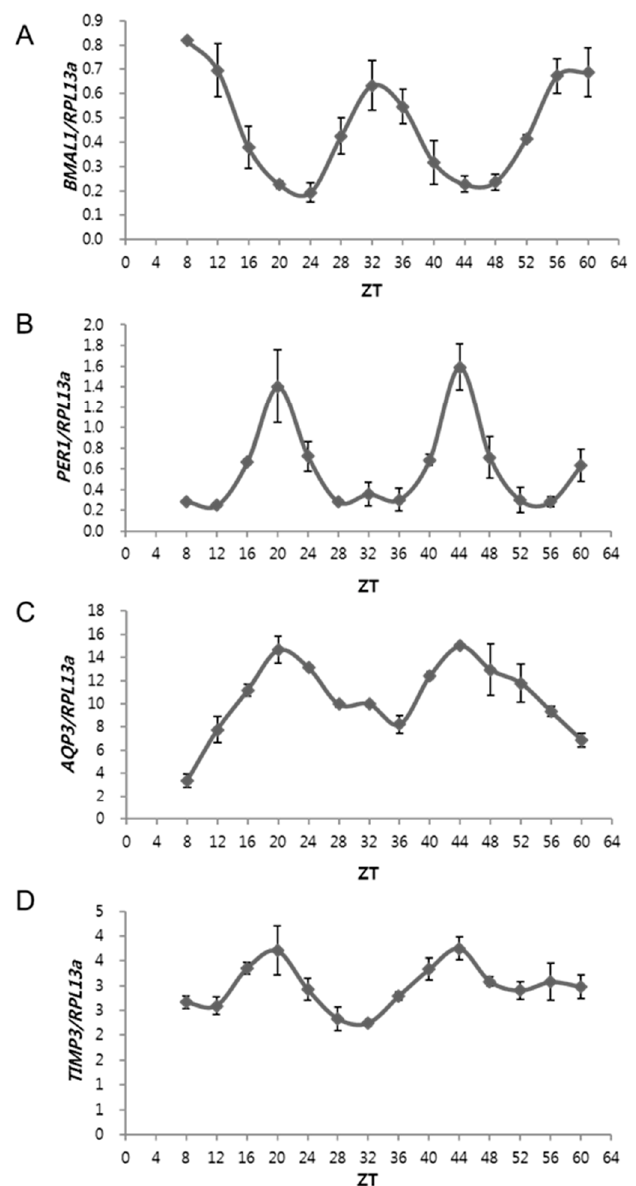
Figure 1. Circadian expression patterns of core clock and clock-controlled genes. Normal human epidermal keratinocytes (NHEKs) were synchronized in a serum-rich medium for 2 h and harvested every 4 h after replenishing with a basal medium. Gene expression patterns of core clock genes, BMAL1 ( A ) and PER1 ( B ), showed periodic oscillation, but were in antiphase to each other. Expressions of AQP3 , ( C ), and TIMP3, ( D ), were oscillating periodically, similar to that of PER1 but was antiphase to that of BMAL1 . Y-axis represents mRNA abundance after being normalized to RPL13a ; ZT indicates Zeitgeber Time (h).